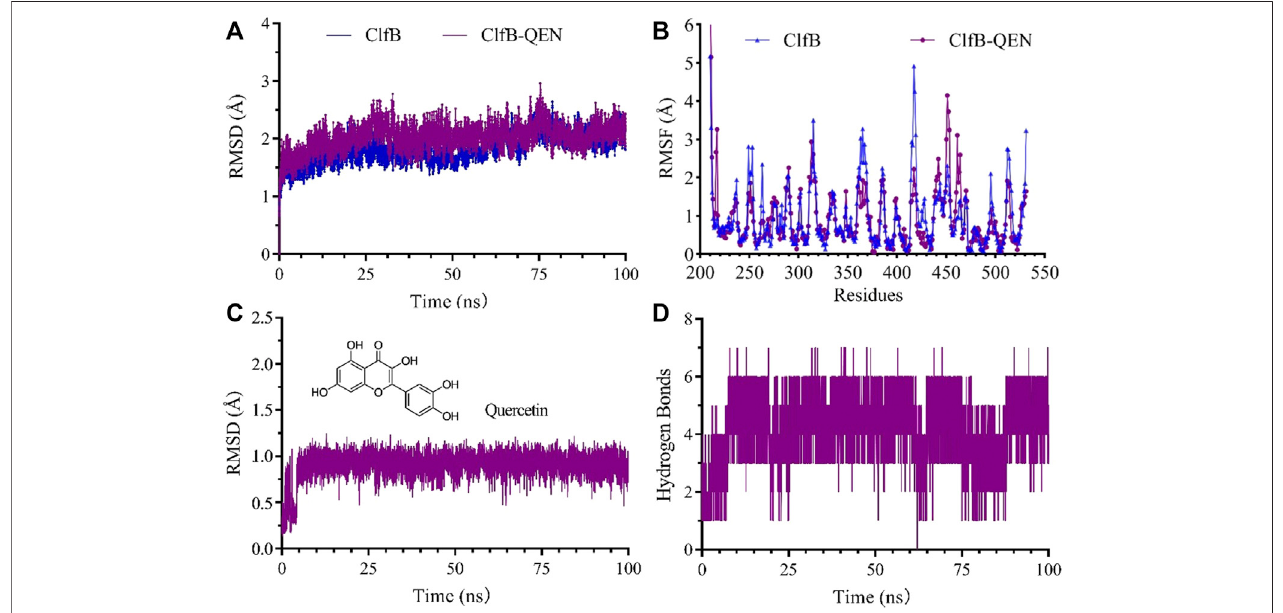
FIGURE 5 | Results of the molecular dynamics simulation. (A) and (B) revealed that the ClfB-QEN compound system remained stable after convergence at 30 ns, andthecompound ’ sRMSDremainedintherangeof1 – 3ÅwithtimeandRMSFremainedintherangeof0 – 2Åamongmostaminoacidresiduals; (C) and (D) indicating that the high stability of the formed ClfB-QEN complex.